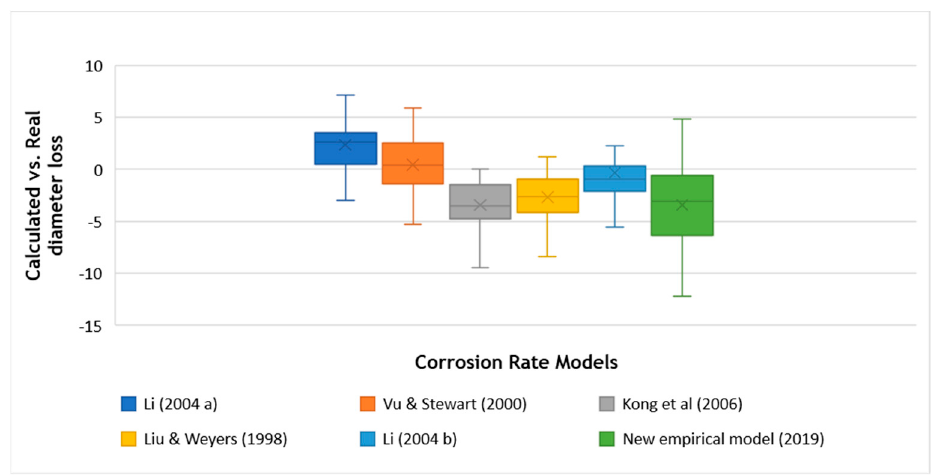
Figure 6. Distribution of estimated vs. real diameter loss in the study cases with different corrosion rate models. rate